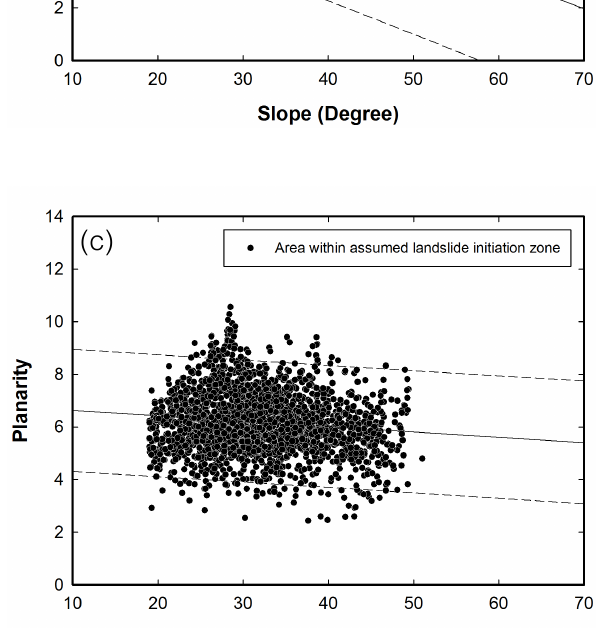
Figure 12. Feasibility evaluation of planarity in Site C. (a) Aerial photograph before the landslide (2009). Yellow circle with dot rep- resents the landslide initiation zone. (b) Modified planarity: areas outlined by a black circle with a diameter of 5m are the landslide initiation zones. (c) Aerial photograph after the landslide (2011). Orange lines indicate observed landslide routes from the landslide initiation zones.